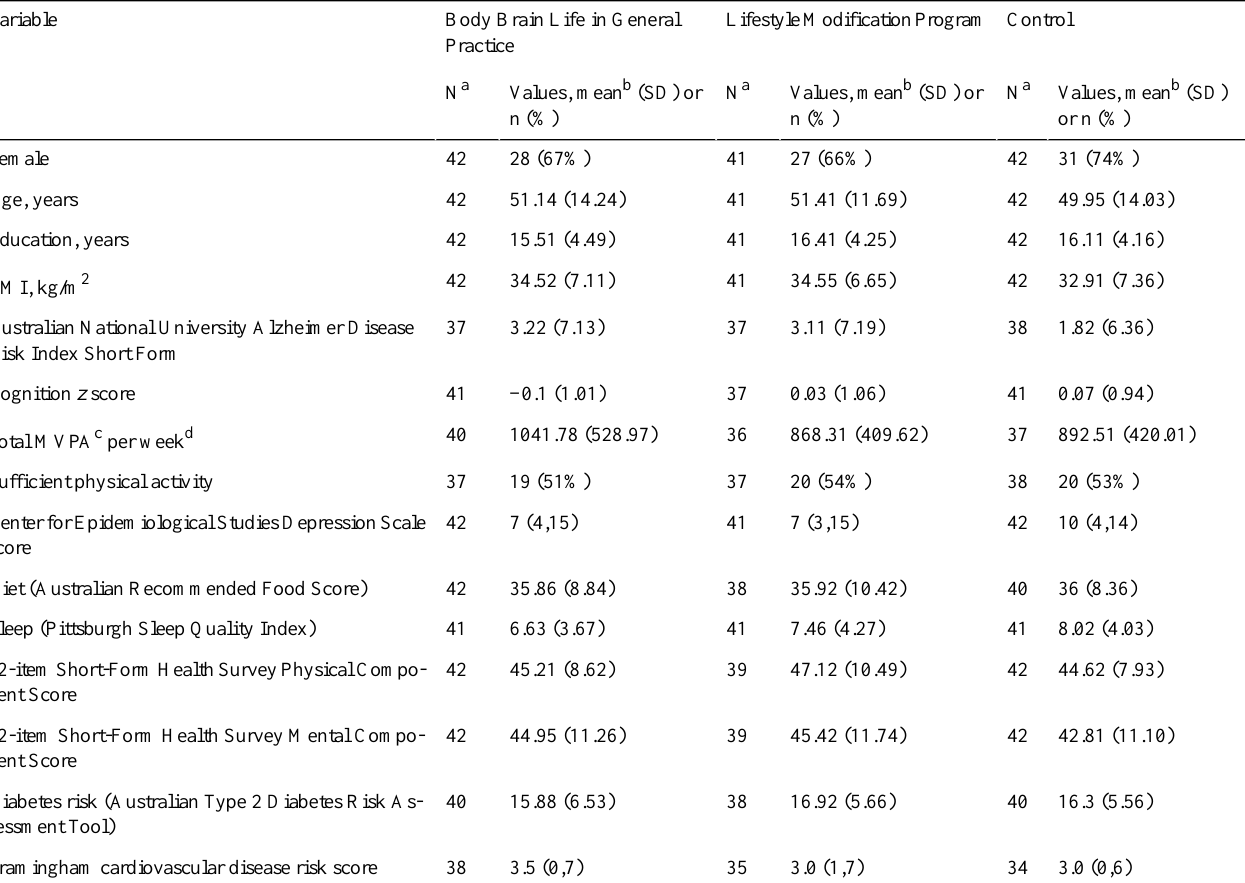
Table 1. Baseline characteristics by intervention group.